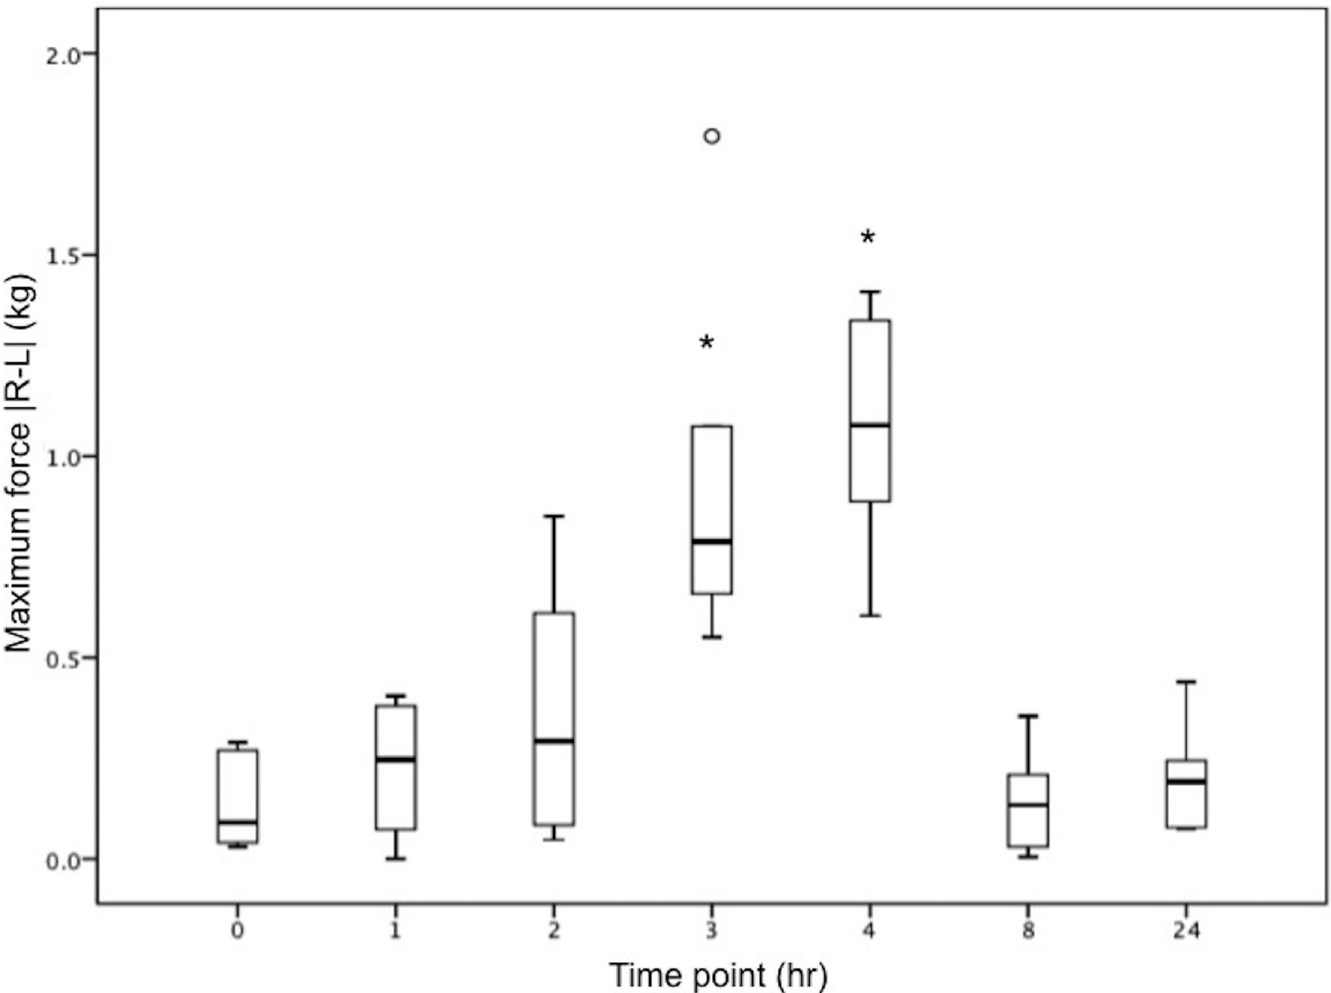
Fig 3. Maximum force. Boxplot depicting the absolute value of the difference between maximum force (kg) of right and left feet of Muscovy ducks ( Cairina moschata domestica ) as measured by a pressure sensitive walkway at serial time points following induction of lameness with intratarsal injection of monosodium urate solution. Asterisks represent a significant increase at hours 3 and 4.